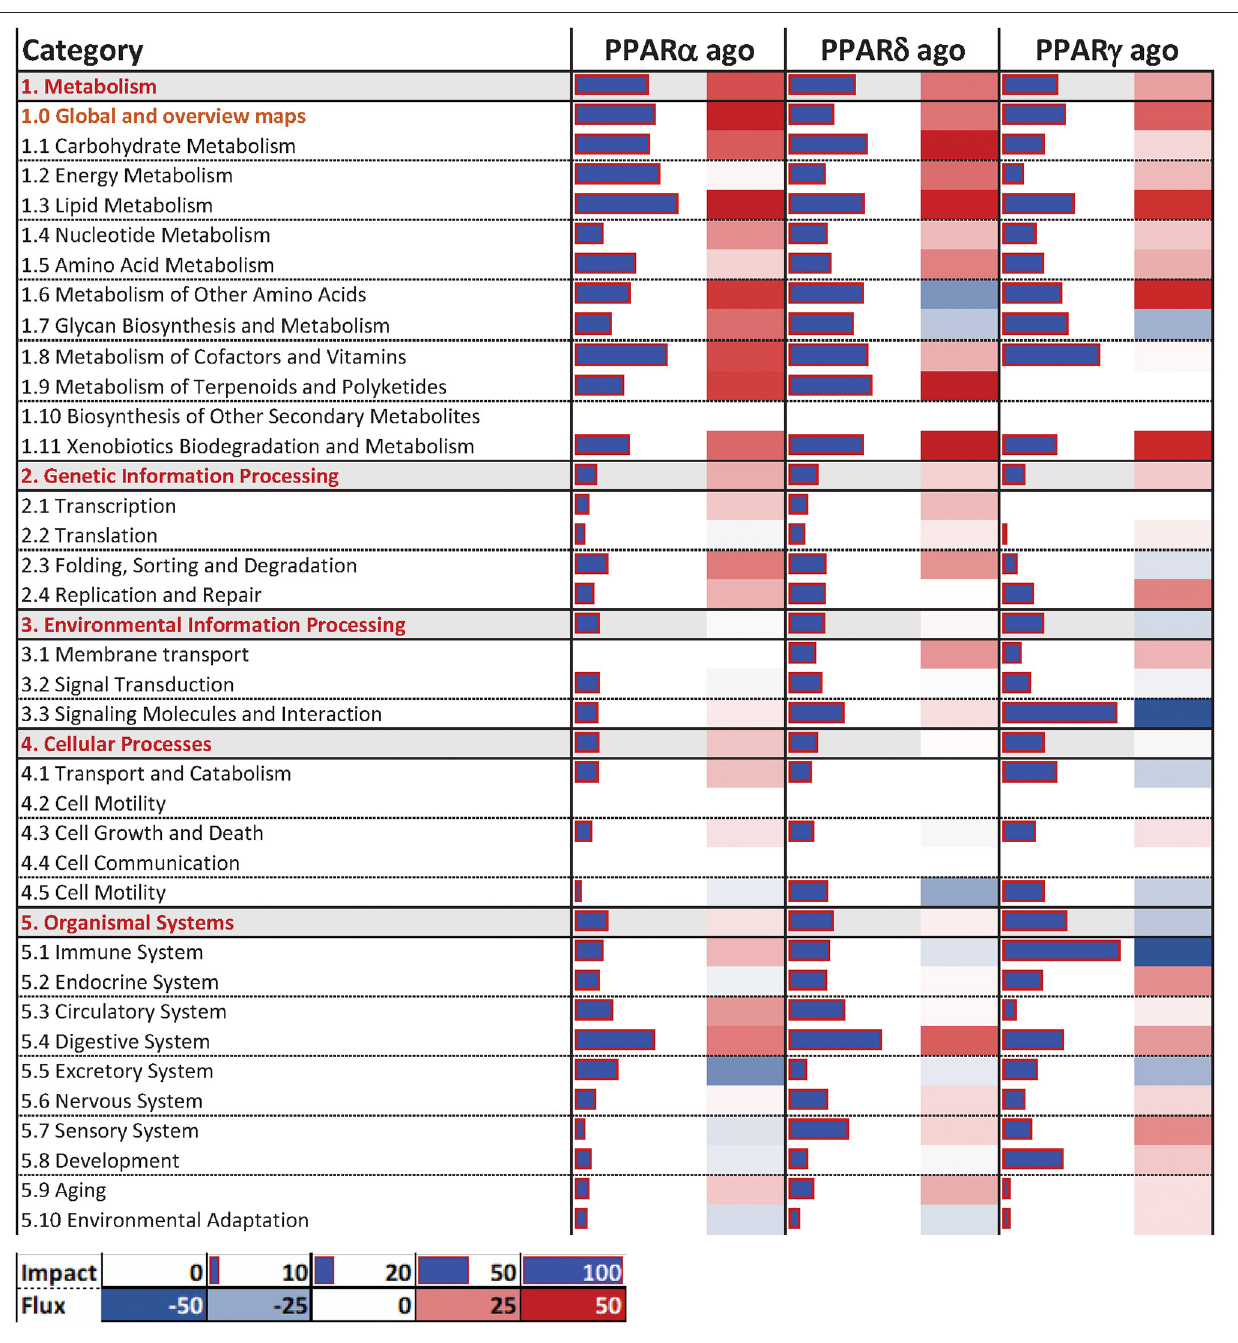
FIGURE 4 | Main categories and subcategories of KEGG pathways induced via the use of isotype-specific PPAR agonists in PCLS, as summarized by the Dynamic Impact Approach. Blue bars refer to the impact in terms of overrepresented genes in the pathways, while the shaded cell denotes the flux, i.e., the overall effect on the pathway, with red denoting activation and green denoting